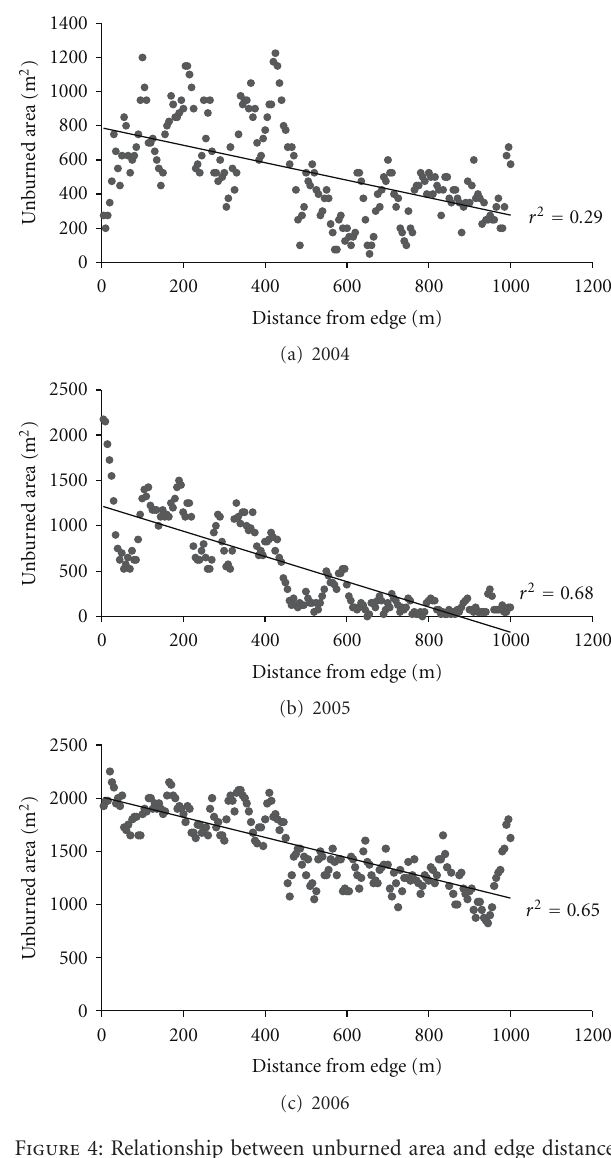
Figure 4: Relationship between unburned area and edge distance in the 50ha annual burn plot in a transitional forest at the Amazon- Cerrado boundary, N =